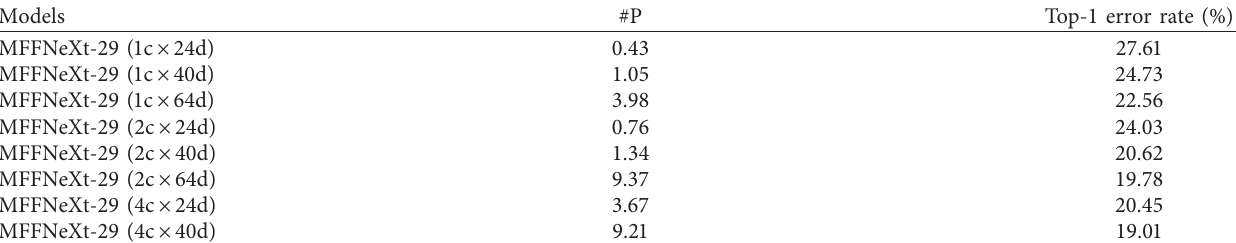
Table 4: Single 224 × 224 cropped top-1 error (%) and complexity comparisons on CIFAR-100. Atrous rate r � 1 , 2 , 3 { } .